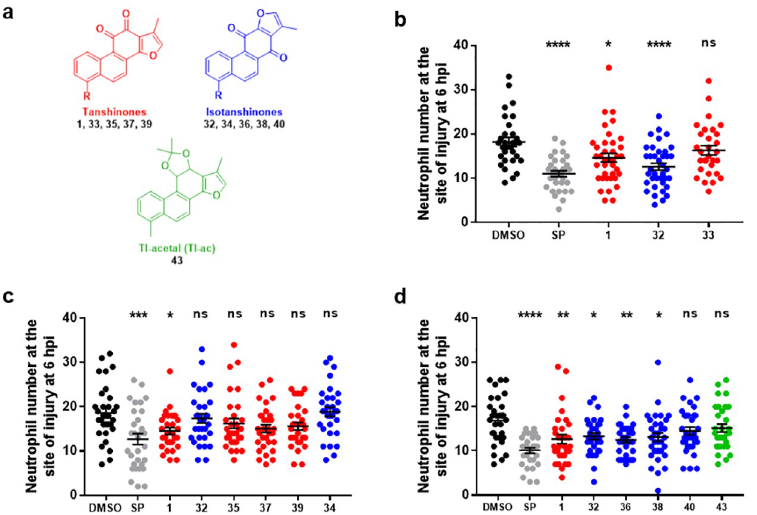
Fig 7. Effects of TI analogues and isomers on neutrophil recruitment. a ) Structures of evaluated tanshinones (red), isotanshinones (blue) and the TI-acetal (green). b )- d ) Tailfin transection was performed on transgenic zebrafish larvae, TgBAC(mpx : GFP)i114 (3 dpf) which were subjected to compound treatments immediately: DMSO (0.5%), SP600125 (30 μ M) and compounds 1 , 32–40 , 43 (25 μ M). Neutrophil number at the site of injury was assessed at 6 hpi